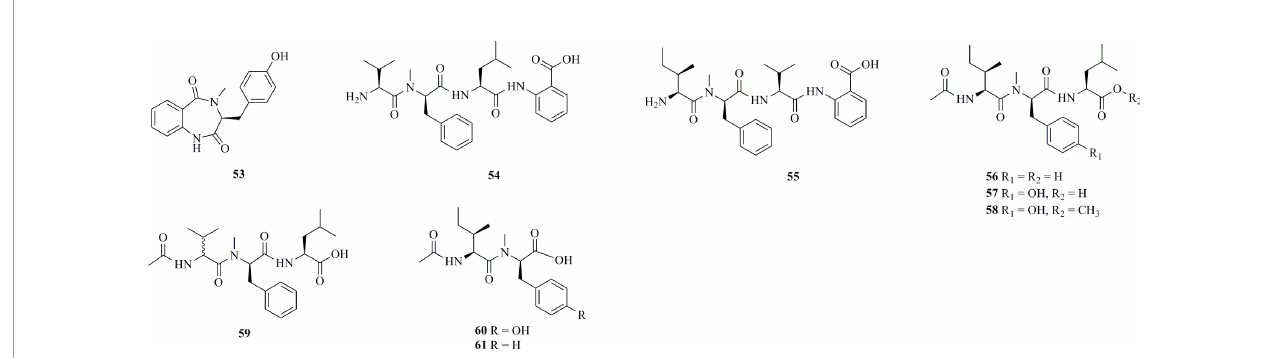
FIGURE 4 | Peptides isolated from deep-sea fungi ( 53 − 61